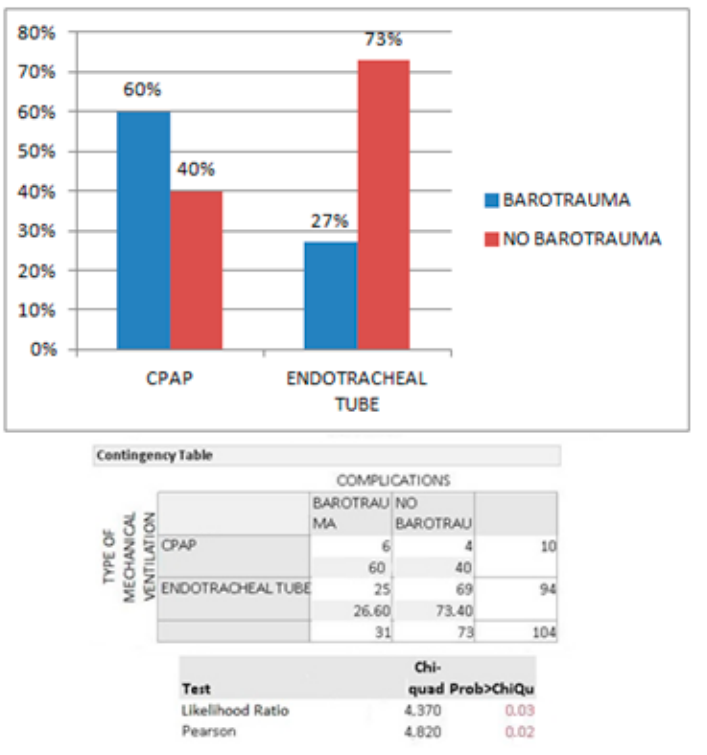
Figure 5. Presence of barotrauma according to type of ventilation in COVID+ patients: p- value is reported in red.